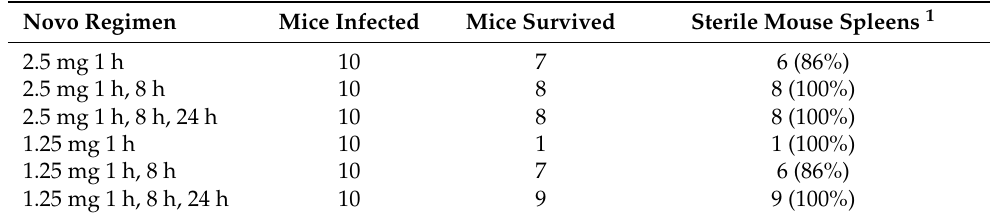
Table 1. The bacterial burden in spleens from novobiocin-treated mice challenged with B. pseudomallei . Novo Regimen Mice